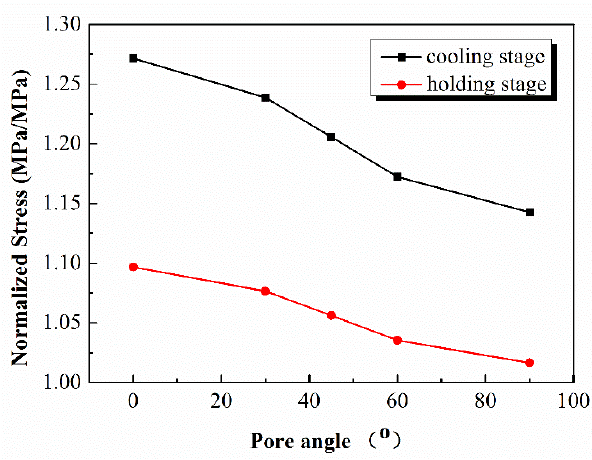
Figure 13. Influence of pore orientation on thermal stress (S22) of TBCs.